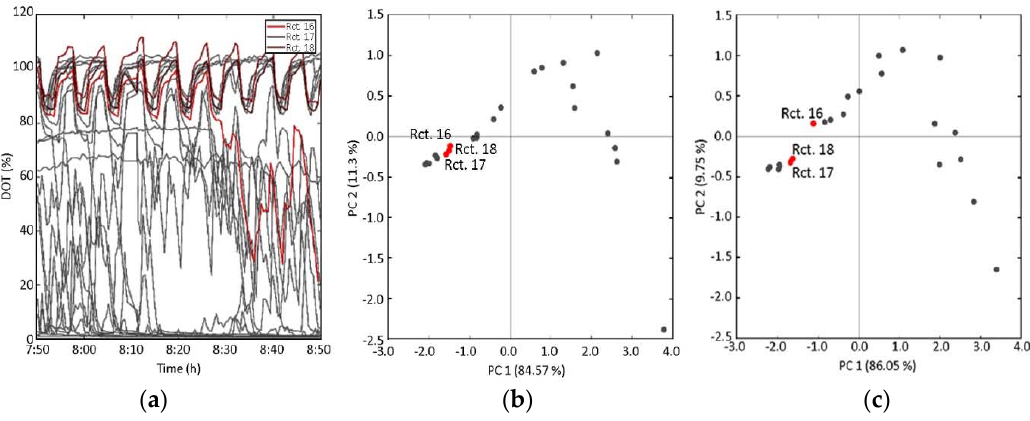
Figure 7. Aeration system blockage. ( a ) Trajectories of the DOT profile from 07:50–08:50 h into the cultivation with highlighted reactors (16,17,18; feed rate: µ set = 40% of µ max ). The DOT profiles of Reactor 16 deviates from its group of replicates, indicating the system stops reacting to the pulse-based feeding. ( b , c ) Score plot based on the sliding window PCA model with input variables pH, DOT, base volume addition, and feed volume addition in the time range t 0 = 08:10 h to t end = 08:30 h ( b ) and t 0 = 08:30 h to t end 08:50 h (c).